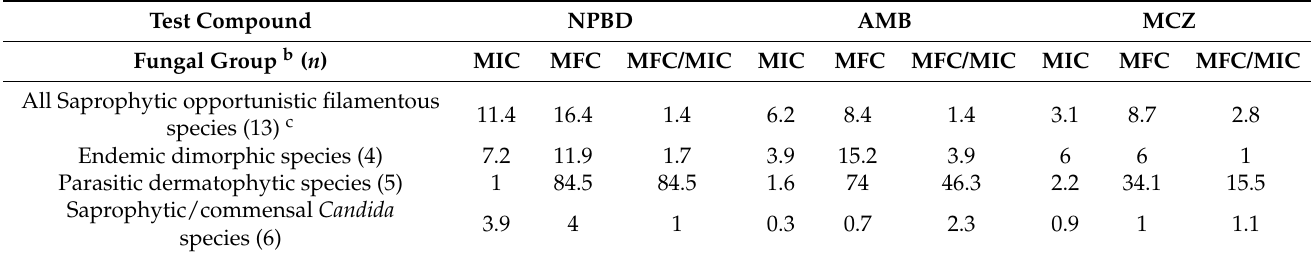
Table 2. Comparison of the activity a of NPBD, AMB and MCZ for major fungal